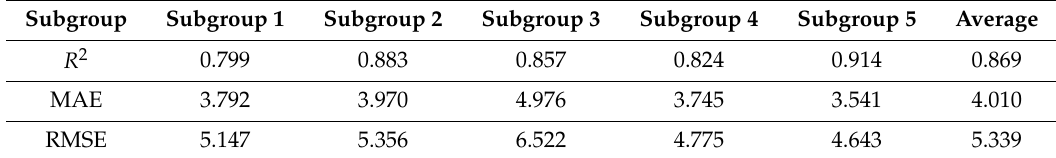
Table 1. The R 2 , MAE, and RMSE of the cross-validated subgroups and their averaged scores.